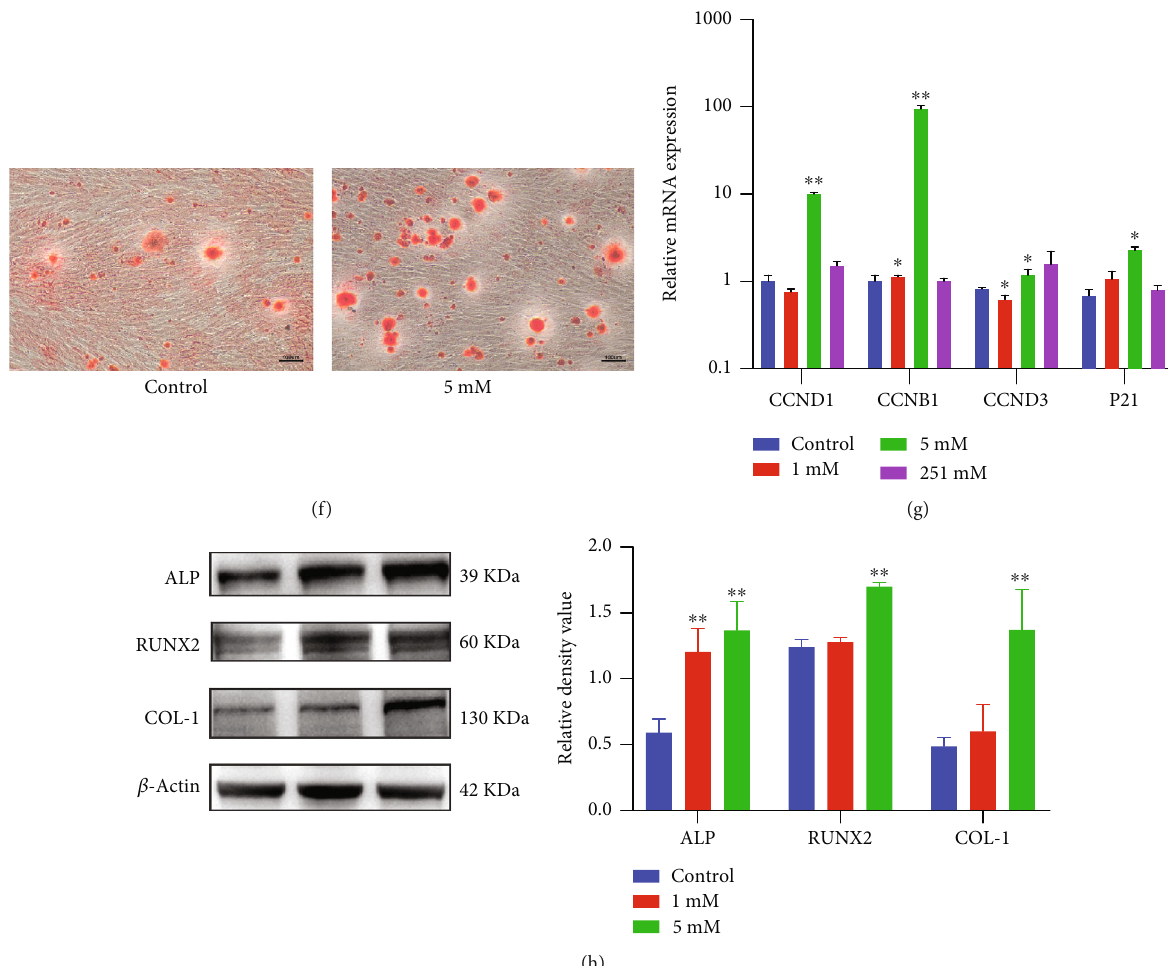
Figure 3: Exogenous succinate promoted proliferation, migration, and osteogenesis in hPDLCs. hPDLCs were treated with 0, 1, 5, or 25mM of succinate. Cell proliferation was observed under the phase contrast microscope at 24 h (a). The CCK-8 assay was used to quantify cell growth (b). Transcription of cell cycle-related genes at 4h was detected by qPCR (c). Scratch-healing model was utilized to analyze cell migration at 24h (d). Osteogenic di ff erentiation was assessed using ALP staining after 7 days and Alizarin Red S Staining after 21 days (e, f). Levels of osteogenesis-related genes in hPDLCs were analyzed by qPCR at 24h ( n = 3 ) (g), and protein expression was detected by western blot at 72h (h). Blots were representative of 3 independent tests. ∗ p < 0 : 05 , relative to control; ∗∗ p < 0 : 01 , relative to